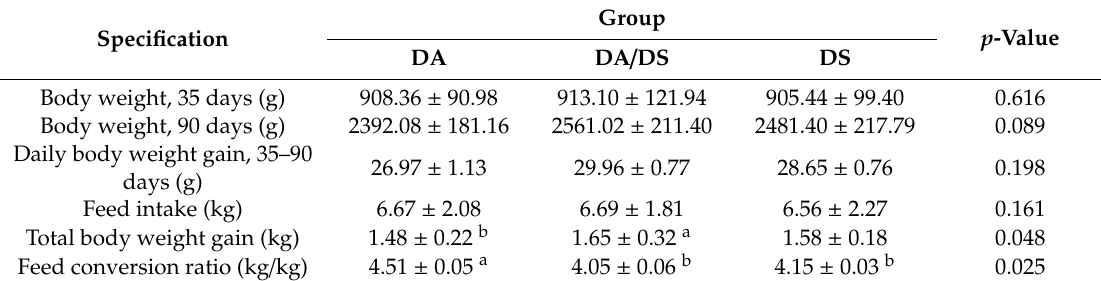
Table 4. Production performance of rabbits (mean ± SD; n = 30).